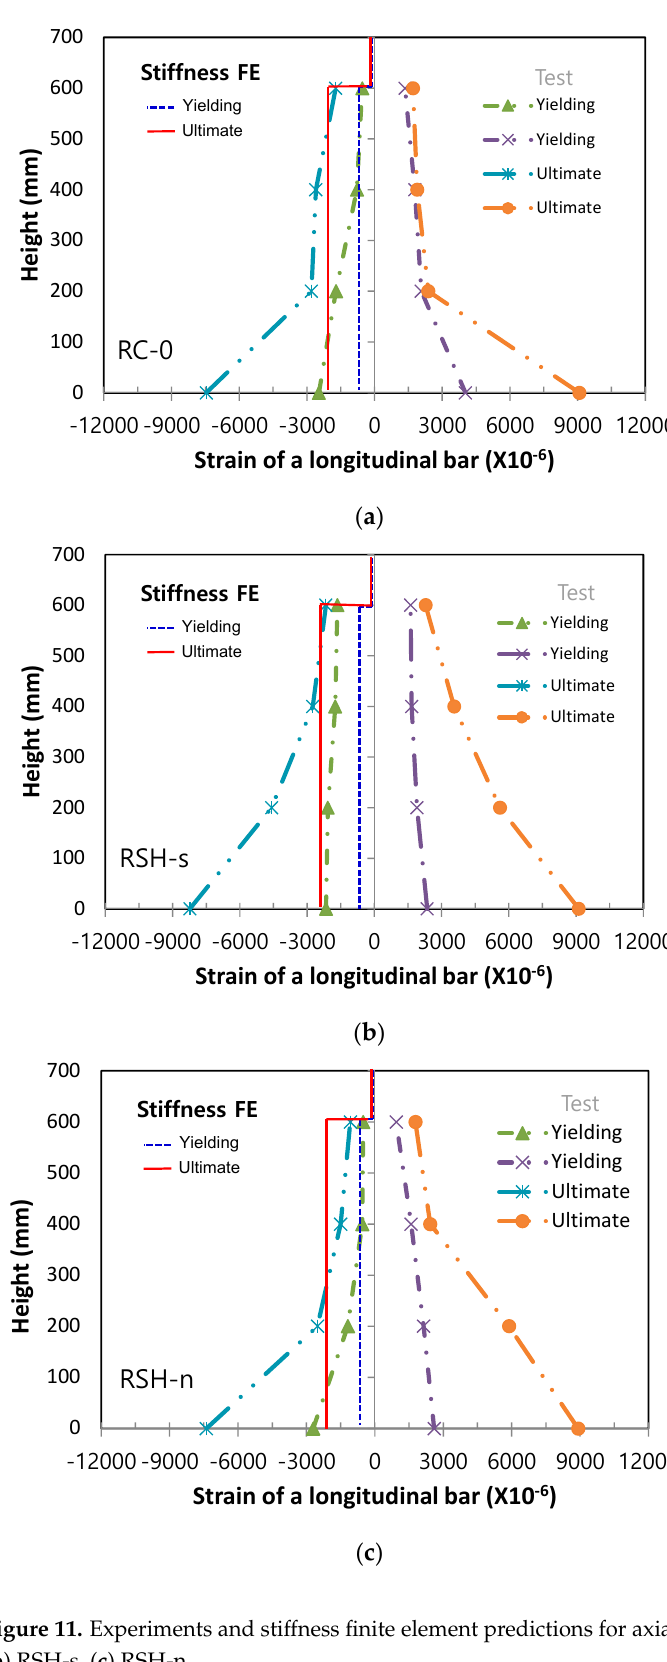
Figure 11. Experiments and stiffness finite element predictions for axial strains of steel bars, ( a ) RC-0, ( b ) RSH-s, ( c )